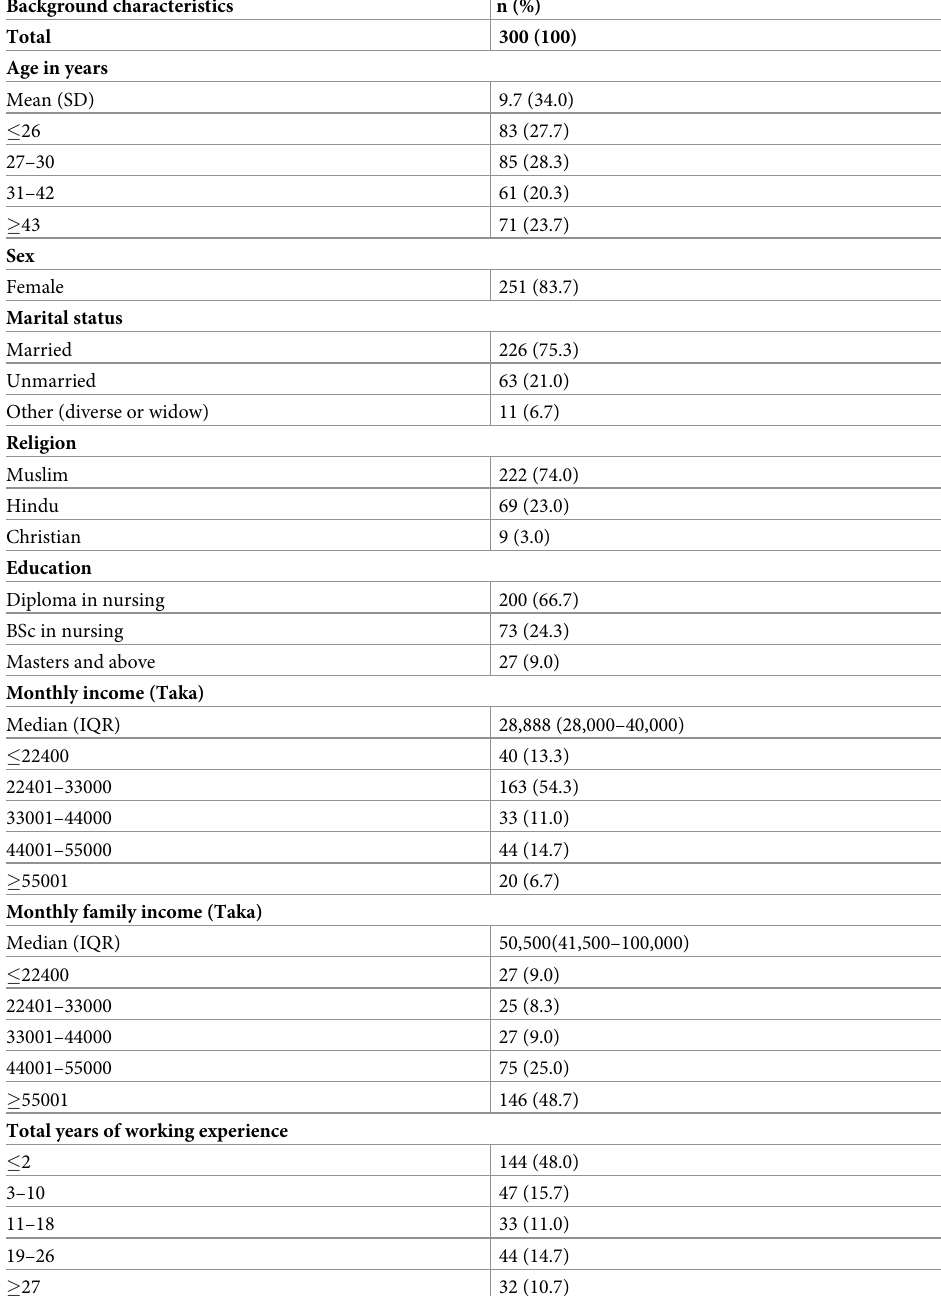
Table 1. Characteristics of nurses in Dhaka Medical College Hospital, Bangladesh (N = 300). Background